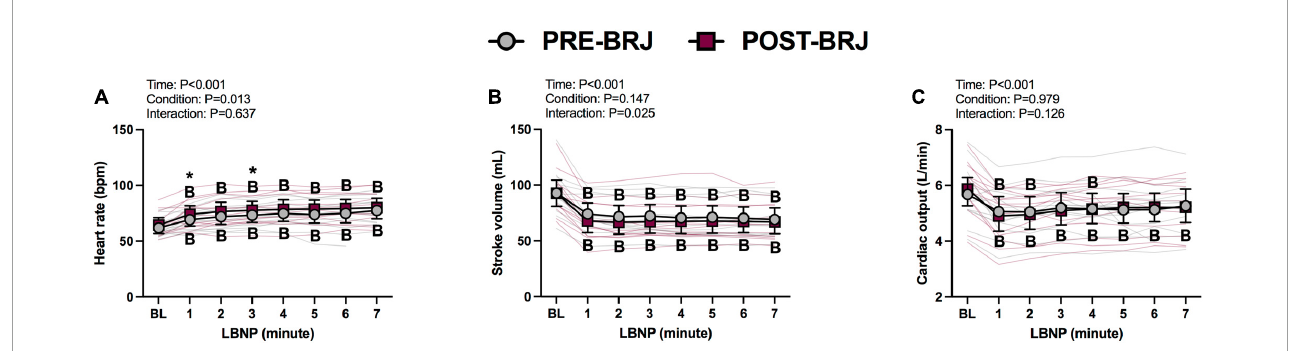
FIGURE4 Individual responses and absolute means with 95% confidence intervals for heart rate (A) , stroke volume (B) , and cardiac output (C) , at the last minute of baseline (BL) and during every minute of static lower-body negative pressure (LBNP) before (PRE–BRJ) and 3 h after beetroot juice consumption (POST–BRJ). Linear mixed-effect models were used to compare mean values within a given variable. Post-hoc tests using the Bonferroni’s correction for multiple comparisons were used where appropriate. B = different from baseline ( P ≤ 0.05). *Different from PRE-BRJ ( P ≤